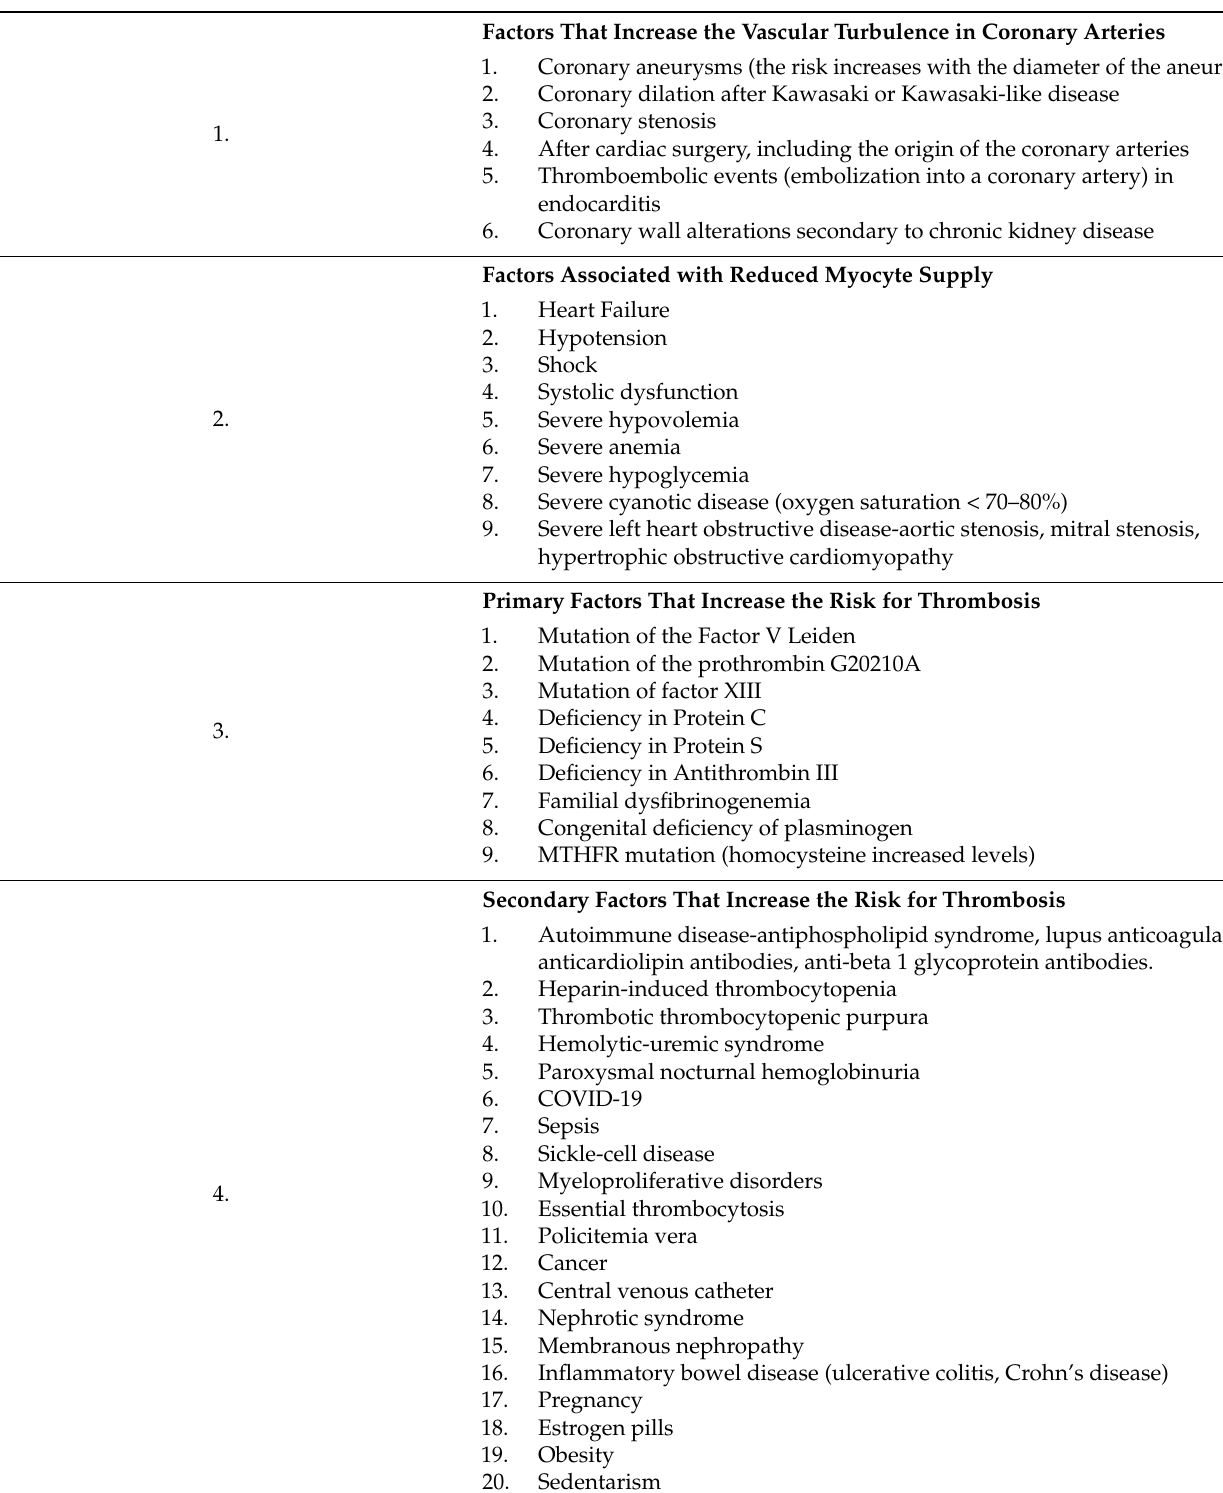
Table 4. Risk factors for an acute coronary syndrome in